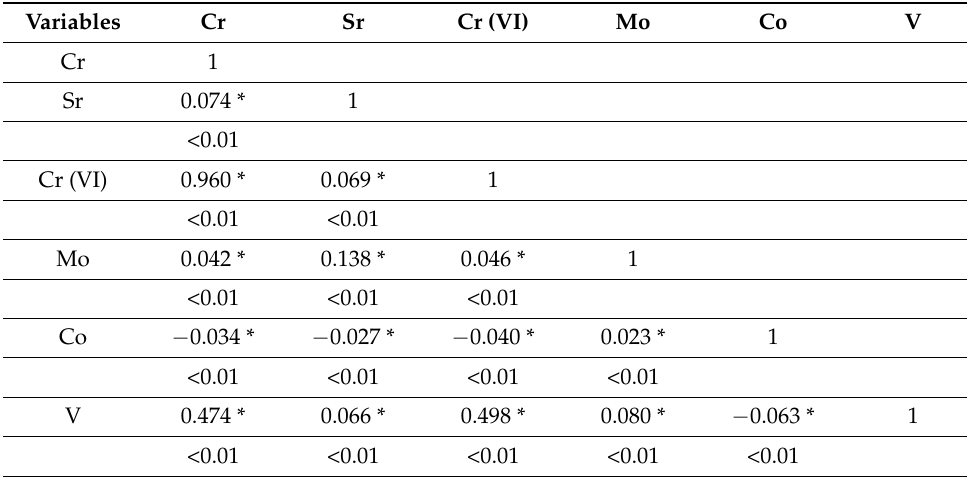
Table 3. Pairwise correlations of predicted geometric means of small public water systems (≤10,000 people served) by contaminant with p value for the correlation on the second line. Variables Cr